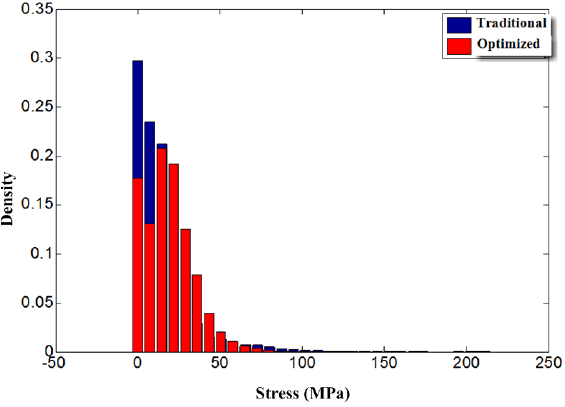
Figure 21. Stress distribution density of traditional and optimized stopper.